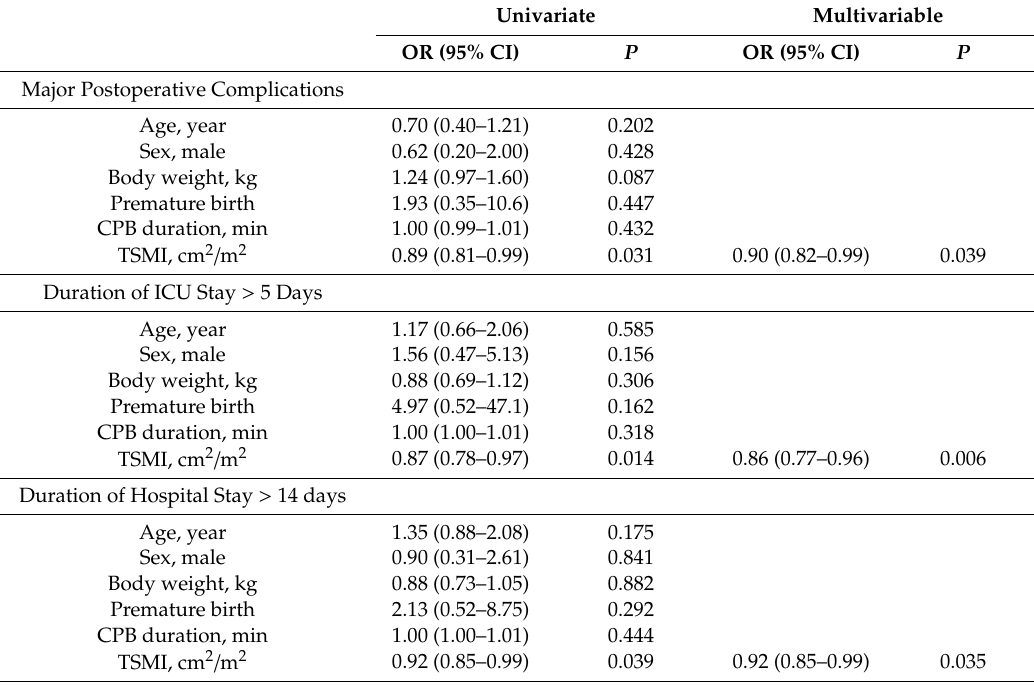
Table 2. Univariate and multivariable analyses of risk factors for poor postoperative outcomes after the Fontan operation. Univariate